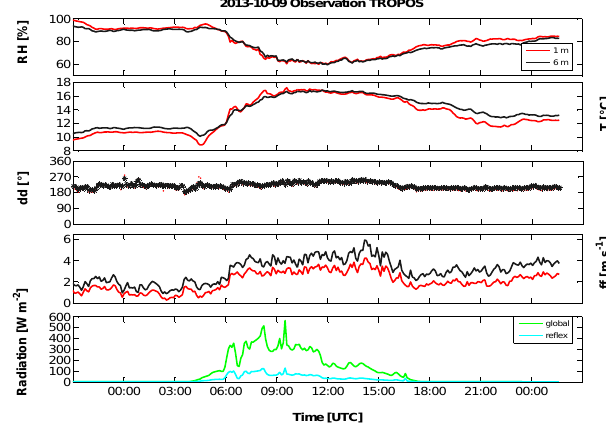
Figure 7. Same as Fig. 6 but on 9 October 2013.